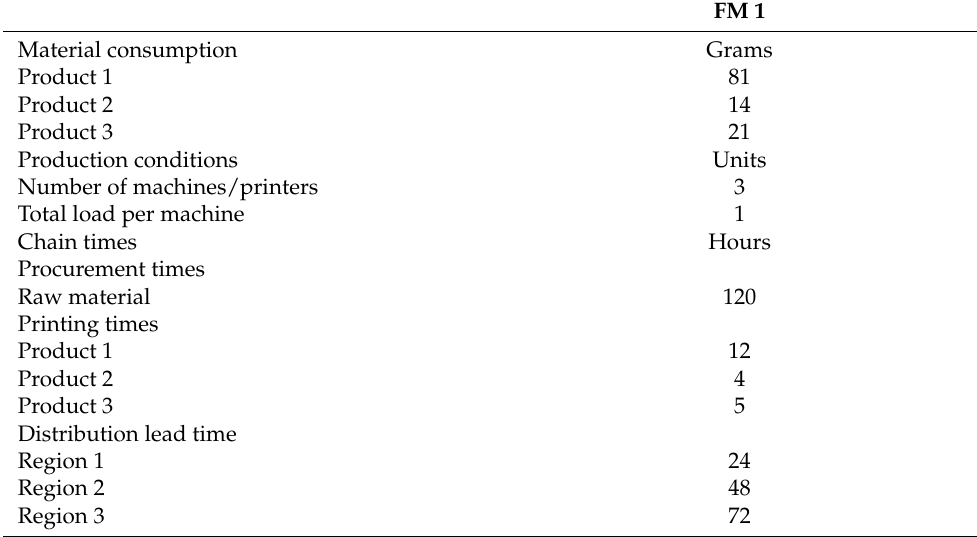
Table 7. Scenario 2 conditions.